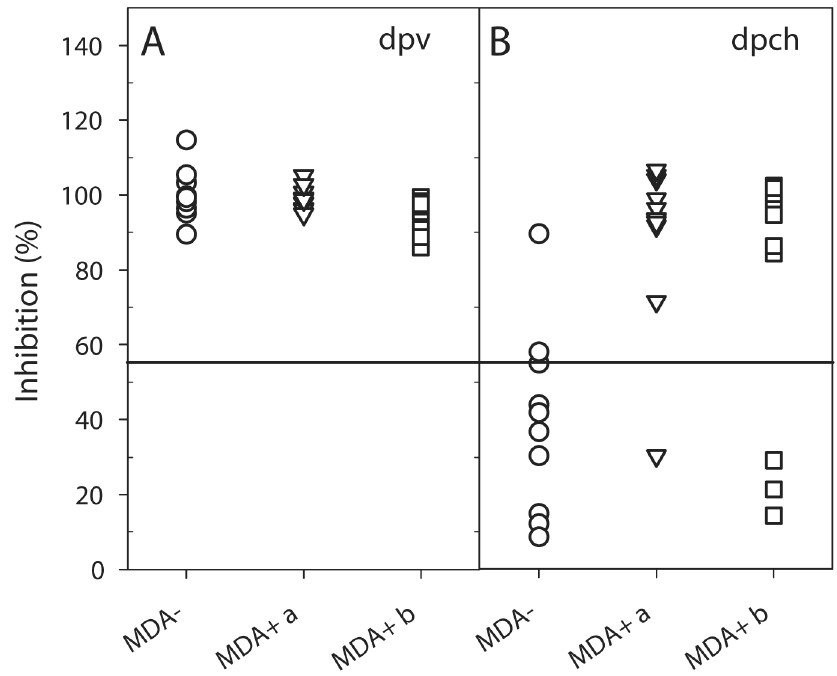
Figure 9. AIV NP-ELISA. Differentiation between vaccinated and infected animals (DIVA) based on antibodies against AIV NP. Sera of chickens collected 20 dpv (MDA-) or 21 dpv (MDA+) (A) and 14 dpch (B) were investigated by a competitive ELISA. Values ≤ 55% are indicative for the presence of AIV NP-specific